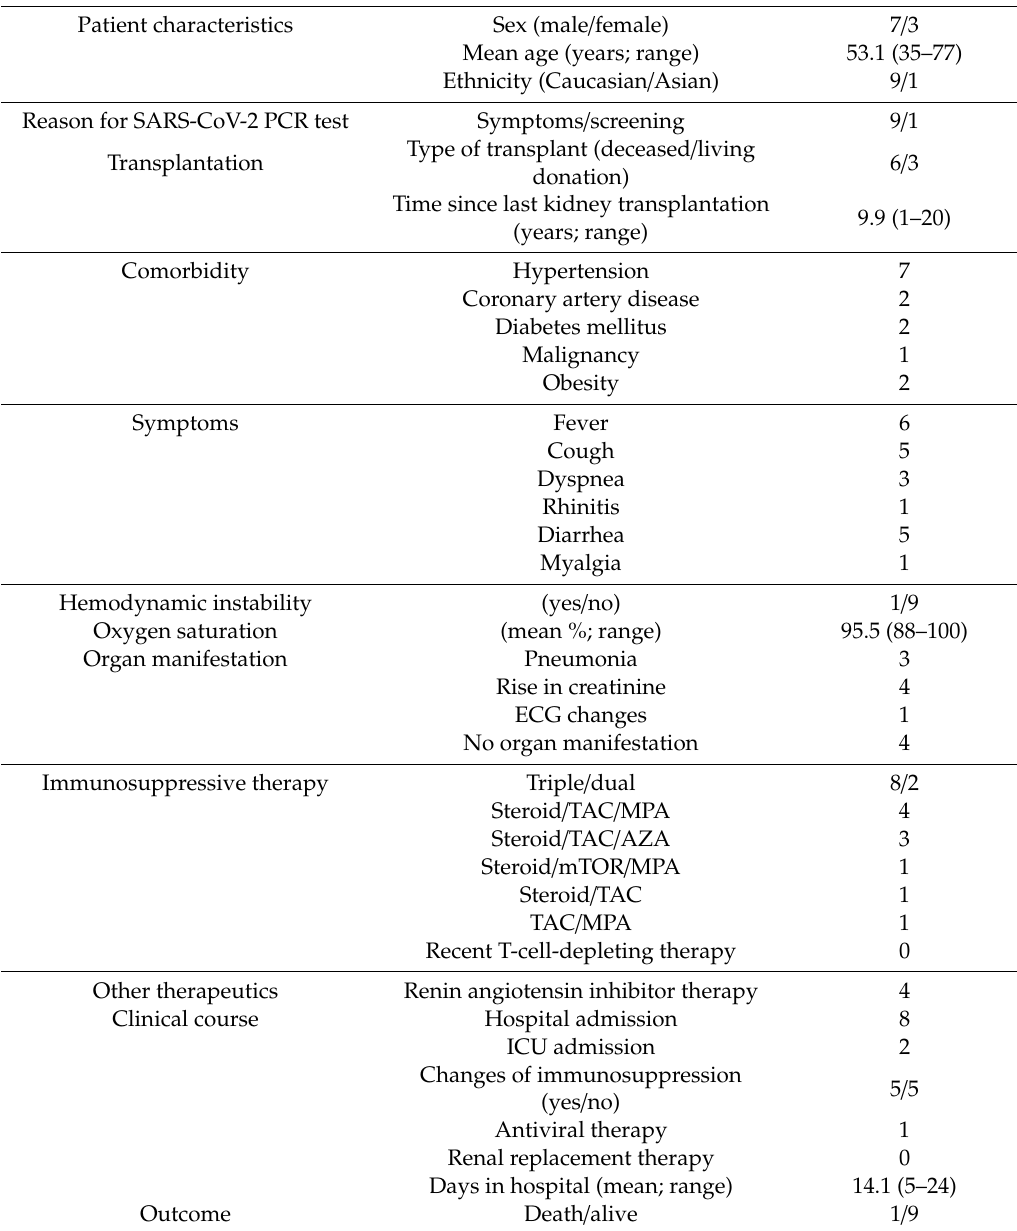
Table 2. Characteristics and outcomes of Austrian kidney transplant patients ( n = 10) with SARS-CoV-2 infection between 28 February and 30 June 2020 (TAC—tacrolimus, MPA—mycophenoic acid, AZA—azathioprine, mTOR—mammalian target of